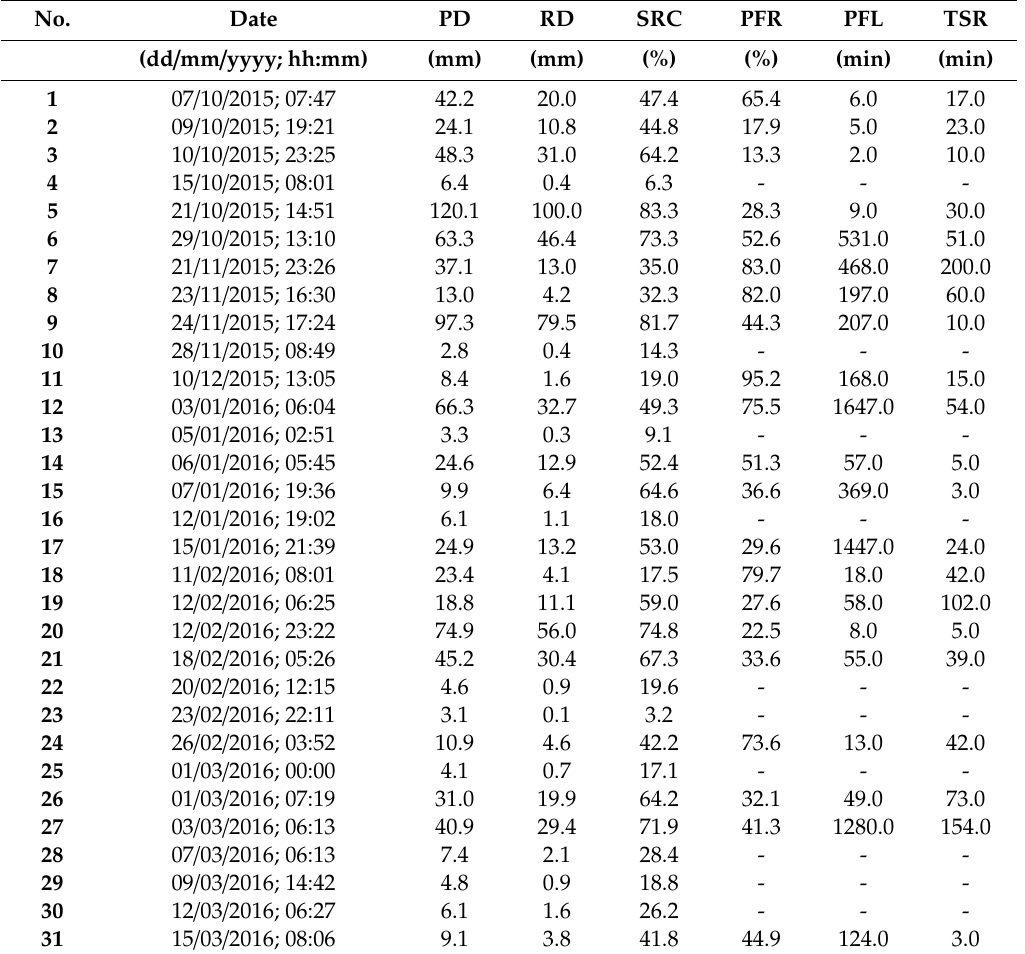
Table 2. Hydrological performance indicators for GR at event scale. PD— precipitation